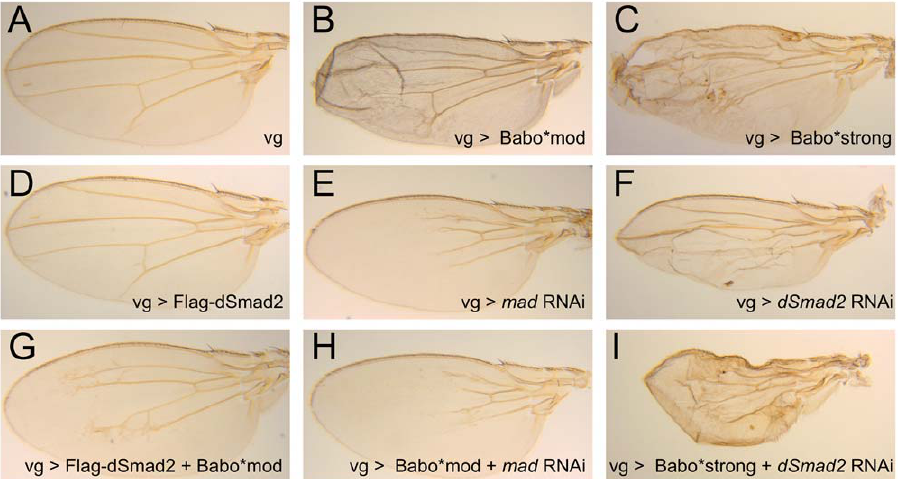
Figure 3. Excessive Baboon signaling perturbs wing development in a Mad-dependent manner. vestigial- GAL4 ( vg ) was used to express combinations of Baboon, dSmad2, and RNAi for mad and dSmad2. Normal wing development (A; one copy of vg -GAL4) was disrupted by Babo* expression (B, C; Babo*mod and Babo*strong are UAS insertions with varying activity as characterized in other assays). The Babo* phenotype was abrogated by simultaneous mad RNAi (H) and resembled mad RNAi alone (E). In contrast, the crumpling defect of Babo* wings was enhanced in conjunction with dSmad2 RNAi (I) and was more severe than dSmad2 RNAi alone (F). Overexpression of FLAG-dSmad2 did not affect wing formation (D), but partially rescued the Babo* overexpression phenotype, producing normal sized flat wings with residual peripheral vein defects (G). For each genotype, a representative wing is shown out of 4–7 wings photographed. Within a genotype there was only slight variation in appearance, except that 3/6 dSmad2 RNAi wings had vein defects and a blister (shown) and 3/6 had vein defects without a blister (not shown).